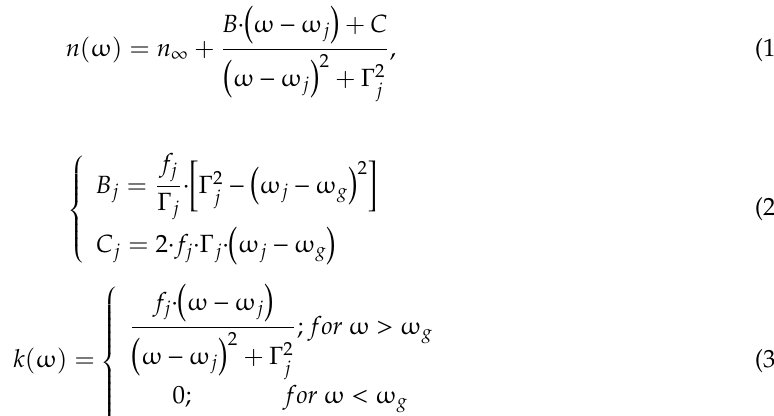
Table 1. Ellipsometric parameters used to simulate the models .